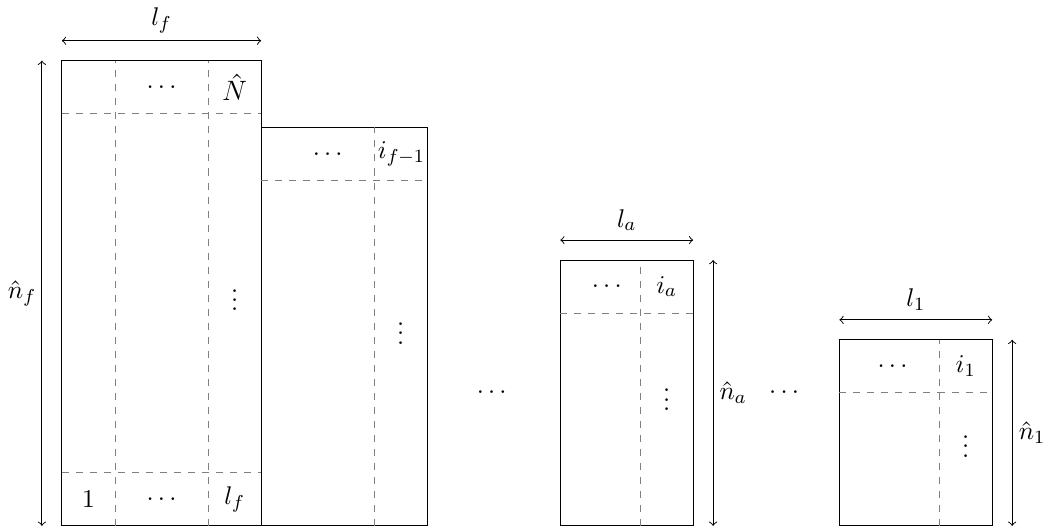
Figure 5. Our conventions for the Young diagram and its labelling. The boxes are labelled from left to right, bottom to top and give a partition of ˆ N . The corner boxes are distinguished and we denote them by i a with a ∈ { 1 , . . . , f } and are defined in (4.17). By construction ˆ N = i f